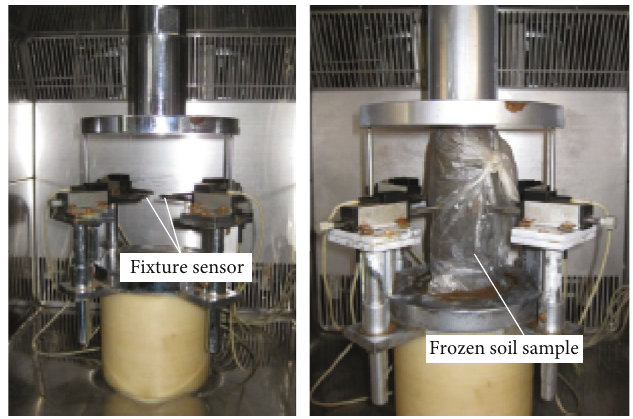
Figure 2: Uncon fi ned compressive strength testing fi xture for frozen